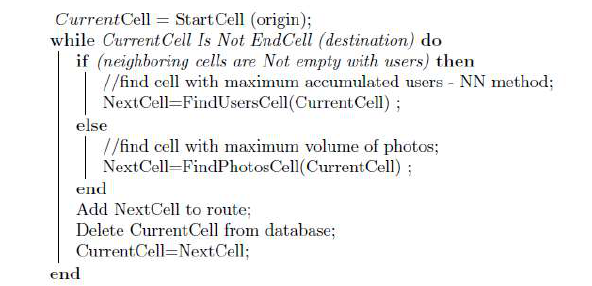
Figure 3. Pseudo-code of the heuristic greedy route optimization algorithm.